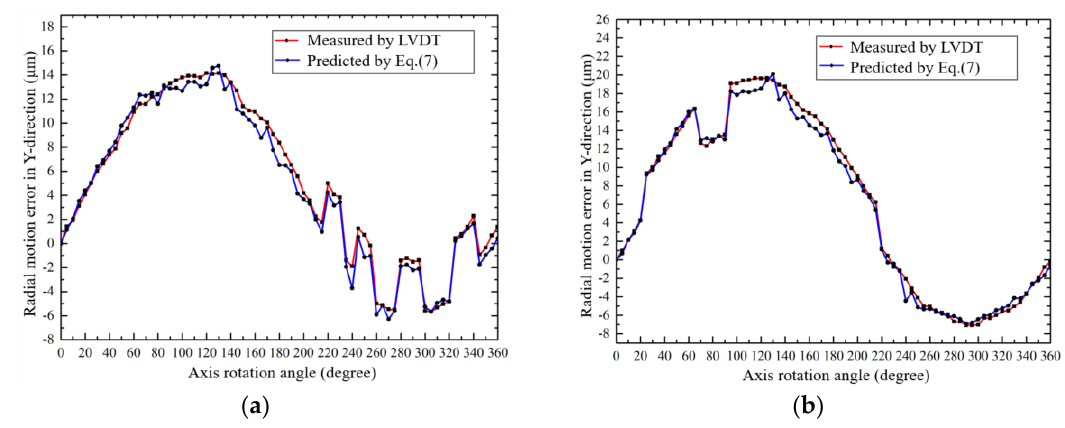
Figure 15. Verification experiments when the external forces were applied on the shaft: ( a ) the 1st time; ( b ) the 2nd time.